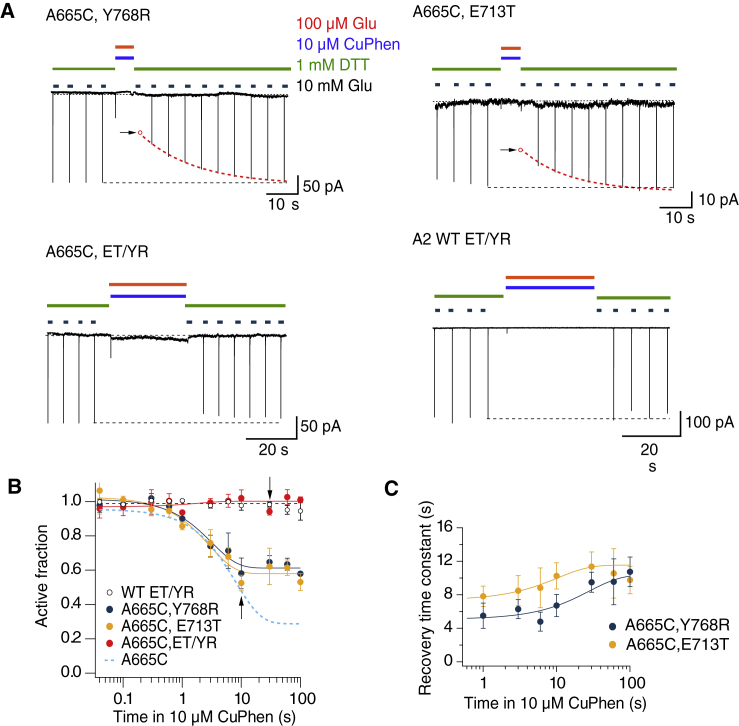
Protection of A665C in deep desensitized states. (A) Typical records show trapping and recovery for the mutants A665C Y768R (upper left) and A665C E713T (upper right). Arrows indicate the reduction of the current after trapping. The presumptive response (open red circle) was extrapolated from the double exponential fits to the recovery (dashed red lines). The mutant A665C on the ET/YR background (lower left) and the GluA2 ET/YR background (lower right) shows no modification. (B) The AF of receptors after oxidization in the desensitized state (continuous lines are exponential fits) is plotted against the trapping interval. The A665C trapping profile (light blue dashed line) and the fit to the ET/YR background (black dashed line) are indicated. The probability of no difference between the AF after 10 s of application of oxidizing conditions was 0.012 and 0.0008 for A665C and Y768R and A665C and E713T (versus A665C and ET/YR, Student’s t-test, n = 3–4 patches per point). Arrows indicate intervals for the traces in (A). (C) Time constants of recovery after trapping plotted against the trapping interval for A665C, Y768R, A665C, and E713T (continuous lines are exponential fits, n = 3–4 patches per point). To see this figure in color, go online.